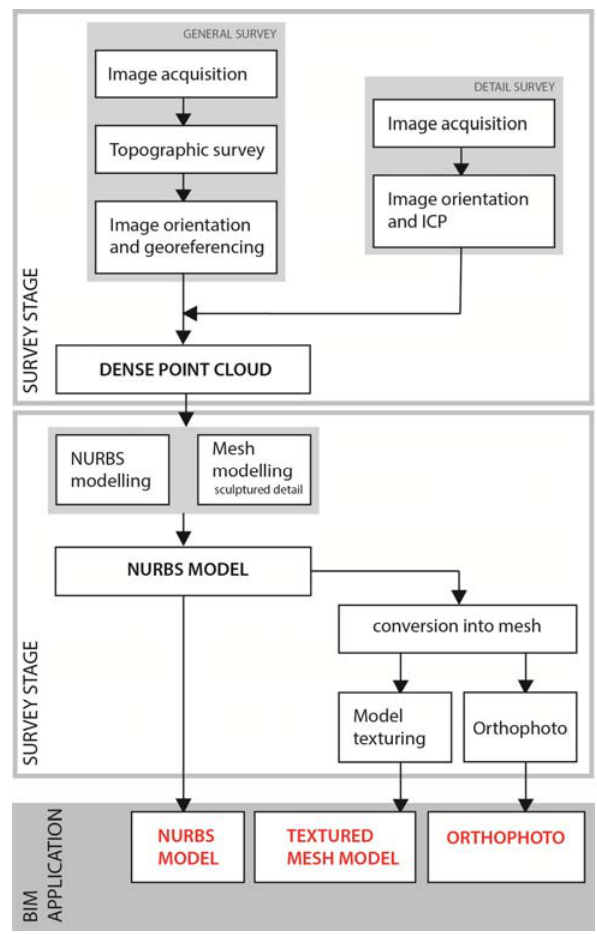
Figure 8:workflow of acquisition and modelling stage